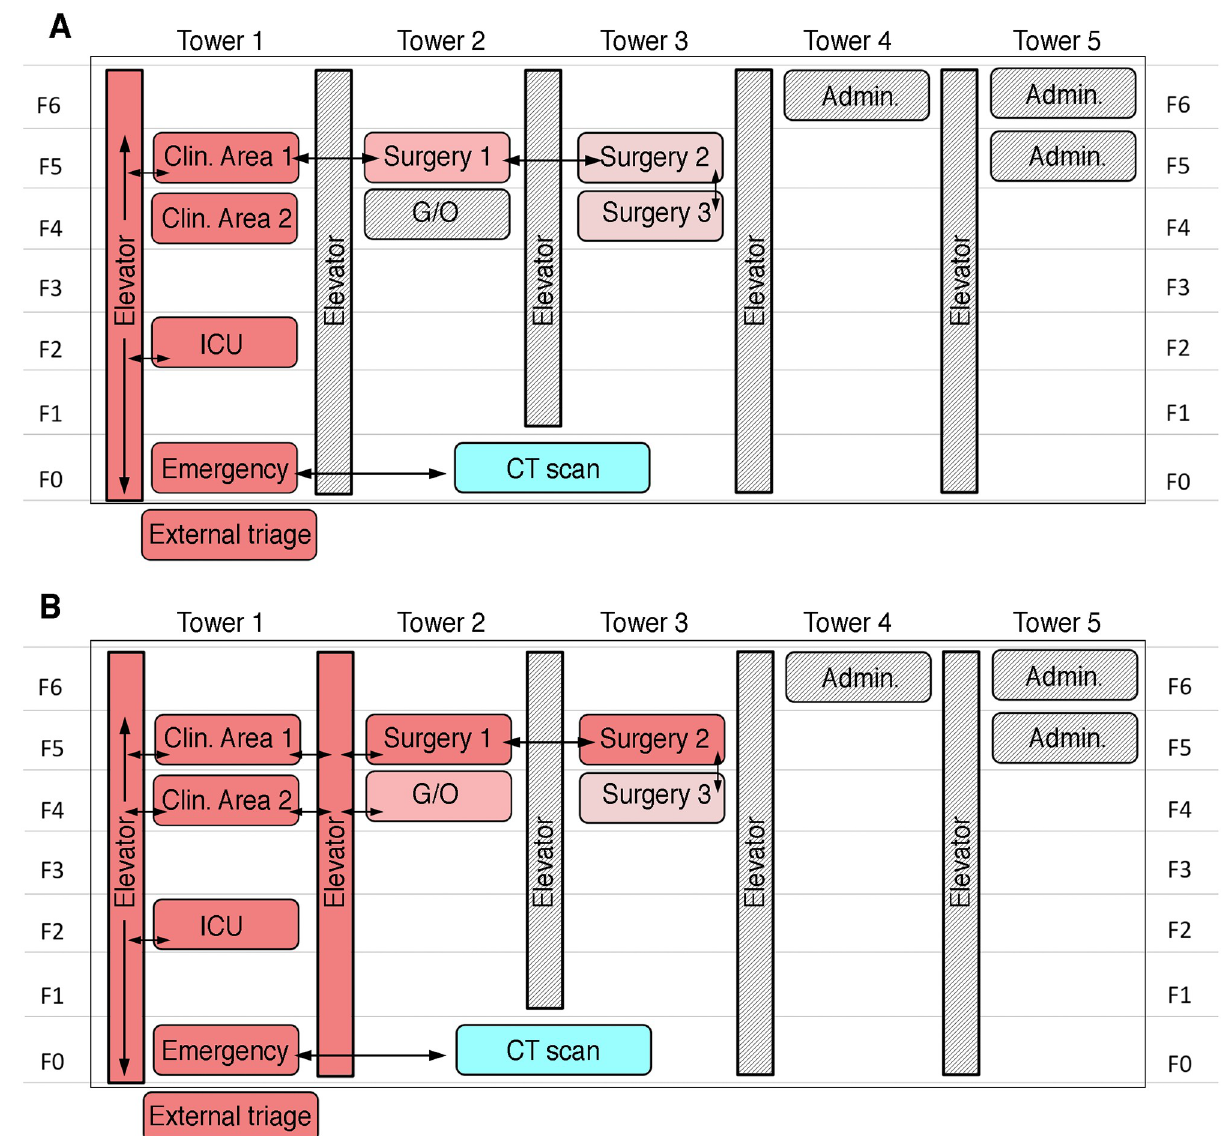
Fig 1. Schematic representation of the Hospital General del Sur de Quito (HGSQ) highlighting specific COVID-19 designated areas. The initial distribution of areas dedicated to COVID-19 patients (i.e., score rooms in red; A) was complemented with newer areas to categorize confirmed, suspected, and negative COVID-19 patients based on laboratory diagnosis and a computer tomography (CT) assisted severity score (B; see text). Different red shading represents areas of high and low COVID-19 transmission risk. Arrows (black) summarize the available patient flow around the hospital with only one elevator available during the first time period (A) and two during the second (B). Areas in grey shading were disabled in order to control movement of personnel. The different floors of the hospital are labeled as F0-F6 in both panels. ICU = intensive care unit; G/O = gynecology and obstetrics; Admin. = administrative offices. CT scan = computer tomography